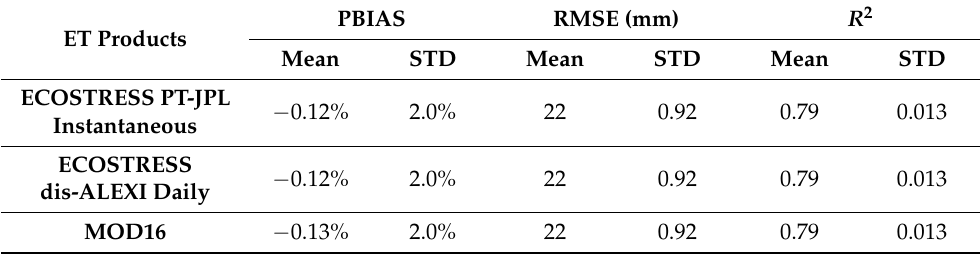
Table 2. Mean value and standard deviation (STD) of percent bias (PBIAS), root-mean-square error (RMSE), and coefficient of determination ( R 2 ) on test data for 2019–2020 from 200 repetitions of the RFR using three ET